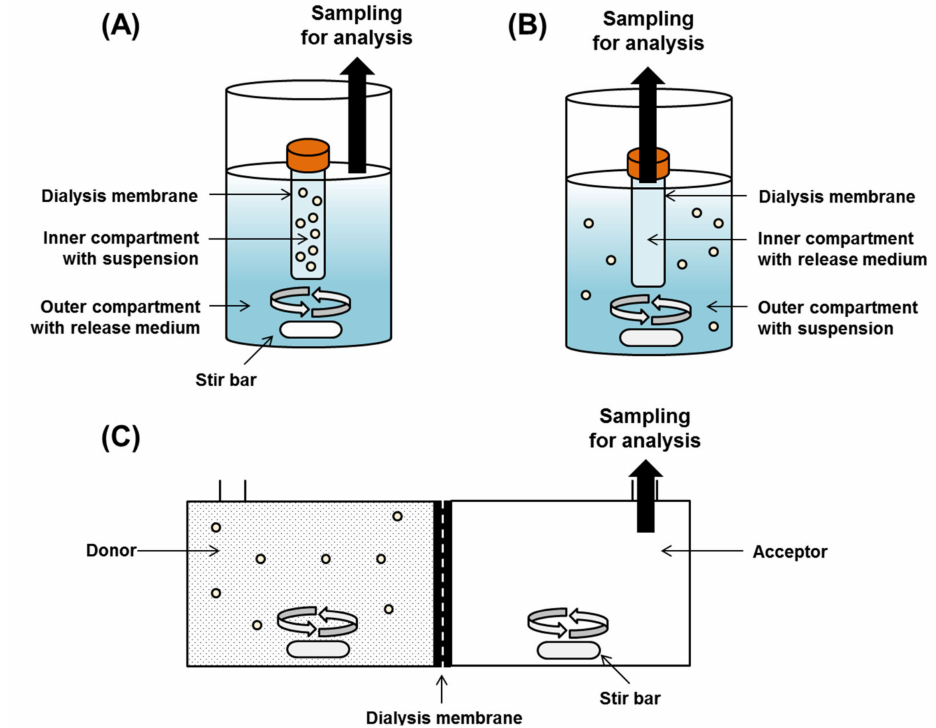
Figure 2. Dialysis membrane methods for in vitro drug release test of particulate formulations: regular dialysis ( A ), reverse dialysis ( B ), and side-by-side dialysis ( C